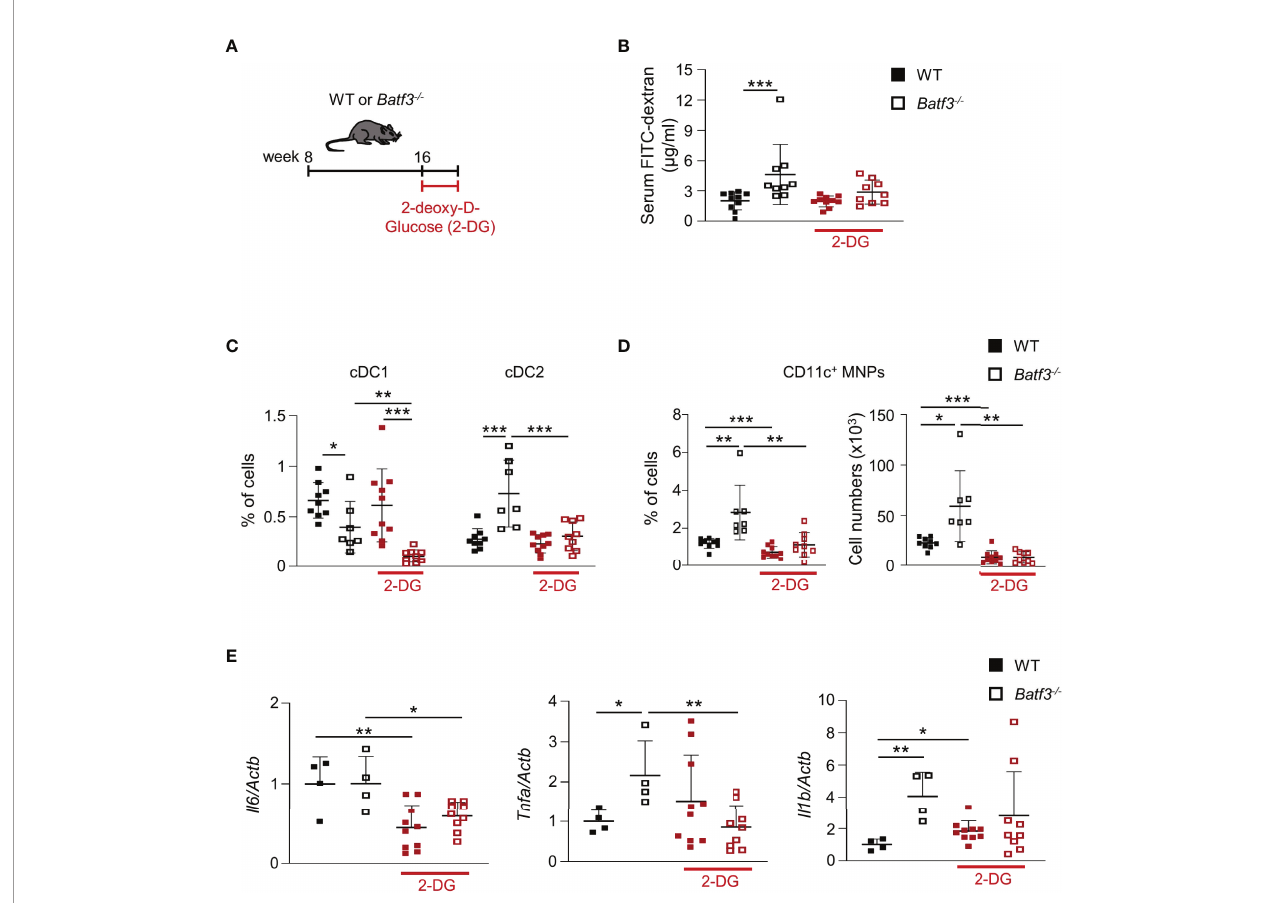
FIGURE 7 | Treatment with 2-DG restores intestinal barrier integrity and reverses the in fl ammatory phenotype in Batf3 -/- mice. (A) Schematic of 2-DG treatment of 16-week-old WT and Batf3 -/- mice. (B) FITC-dextran serum concentration of WT and Batf3 -/- mice before and after treatment with 2-DG (n = 9-10/genotype). (C, D) Percentages of lamina propria cDC1, cDC2 (C) , and CD11c + MNPs, percentage of cells (left panel), total number of cells per large intestine (right panel) (D) measured by fl ow cytometry (n = 9-10/genotype). (E) mRNA expression of Il6, Tnfa , and Il1b in the cecum of mice treated with 2-DG for 10 days as measured by qPCR. All data were normalized to expression of Actb and represented as fold changes compared to WT mice (n = 9-10/genotype). Data are represented as means ± SD. Statistical signi fi cance was determined by Student ’ s t -test (C – E) , or Mann-Whitney-U test (B) . * p < 0.05, ** p < 0.01, *** p <